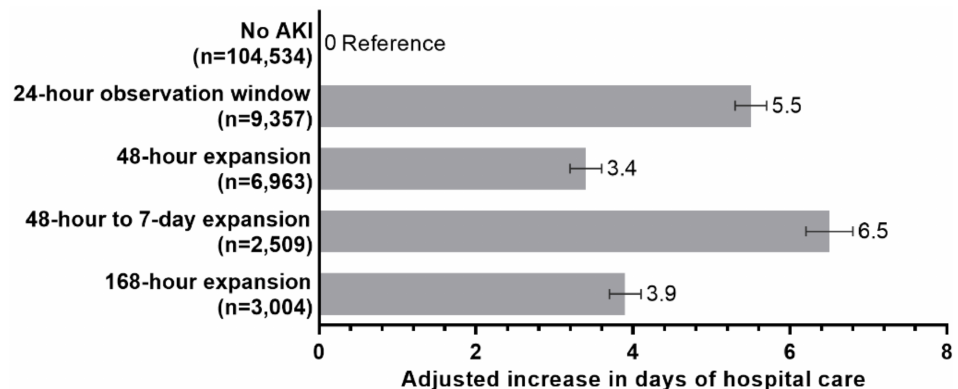
Figure 2. Increased days of hospital care by observation window expansion ( n = 126,367). AKI, acute kidney injury; KDIGO: Kidney Disease Improving Global Outcomes. Adjusted mean difference in days of hospital care and 95% confidence intervals (lines) were calculated using bootstrap sampled multivariable logistic regression, where the reference category was patients who did not develop AKI. Logistic regression was adjusted for hospital admission status (elective/unknown, urgent, and emergency), estimated GFR in categories of 15 mL/min/1.73 m 2 based on first hospital serum creatinine, gender, hospital type (academic medical center vs. community hospital), and baseline comorbidities of diabetes, anemia, hypertension, congestive heart failure, liver disease, and peripheral and visceral